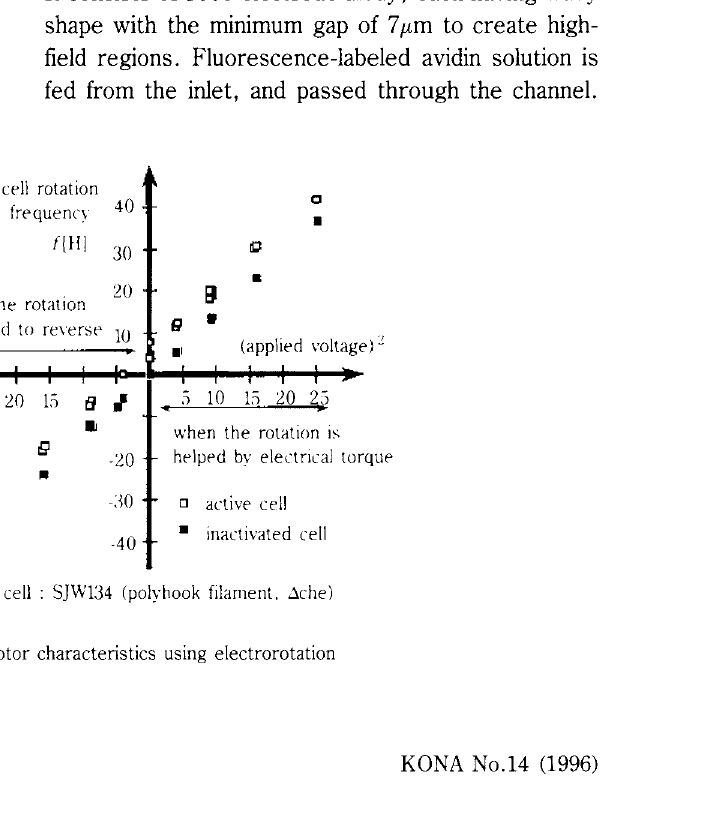
Fig. 6 Measurement of bacterial motor characteristics using